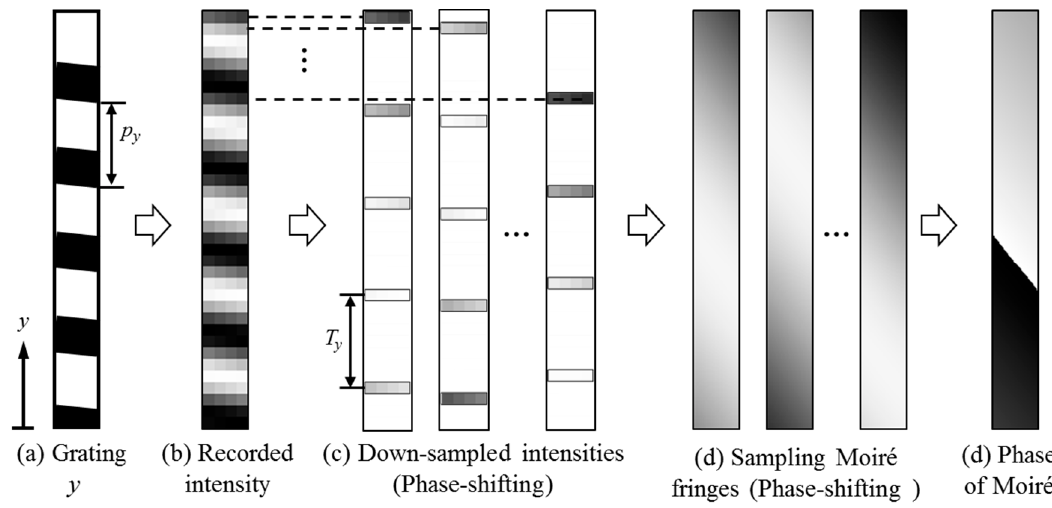
Figure 1. Phase measurement principle of the sampling Moir é Figure 1 . Phase measurement principle of the sampling Moiré method.